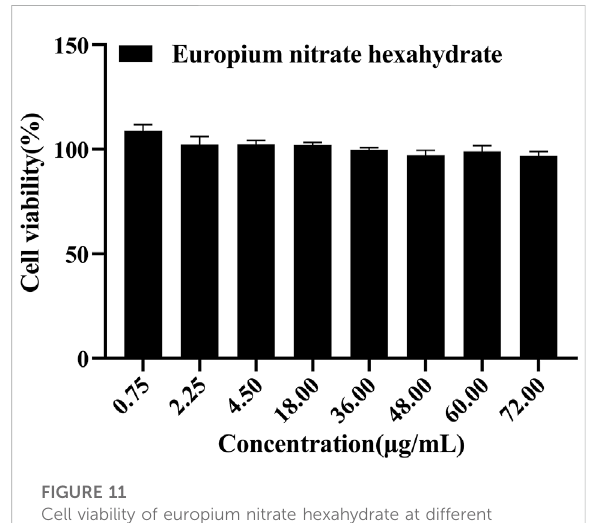
FIGURE 10 Cell viability of cytarabine and Eu-CP-Ara at different concentrations on L02 cells (0.75, 2.25, 4.5, 18, 36, 48, 60, and 72 μ